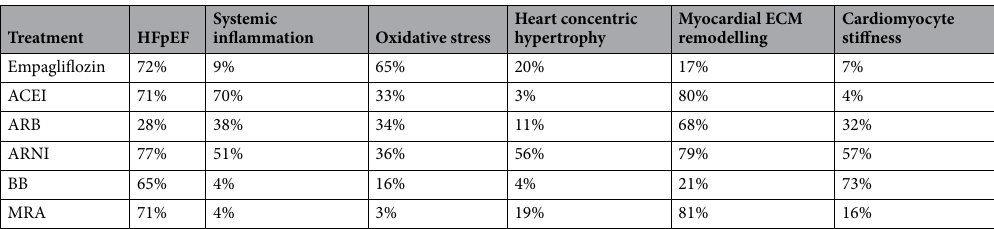
Table 2. Efficacy benchmarking of empagliflozin and other therapeutic treatments in HFpEF. The columns show the artificial neural networks (ANN) score obtained (in %) for each drug in HFpEF (as a whole) and in each individual pathophysiological motif. HFpEF, heart failure with preserved ejection fraction; ACEI, angiotensin-converter enzyme inhibitors; ARB, angiotensin receptor blockers; ARNI, angiotensin-receptor neprilysin inhibitors; BB, β-Blockers; MRA, mineralocorticoid receptor antagonists; ECM, extracellular matrix.